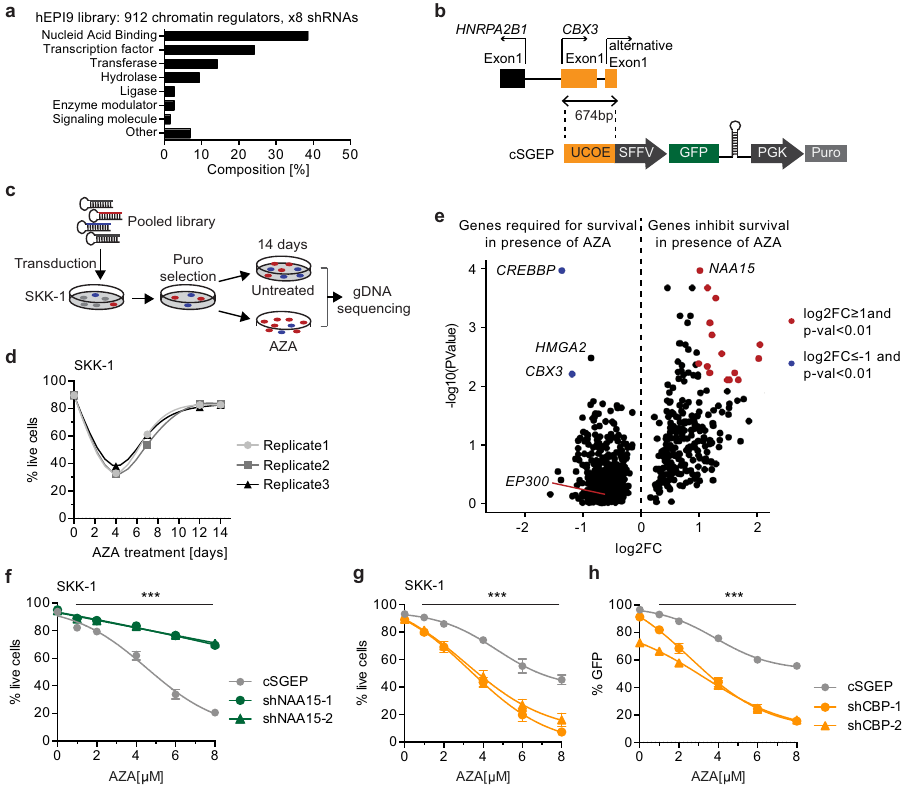
Fig. 1 Chromatin regulators affecting AZA sensitivity are identi fi ed by an optimized loss-of-function shRNA screen. a Composition of the hEPI9 library. b Illustration of the human HNRPA2B1-CBX3 locus including the ubiquitous chromatin opening element (UCOE) and schematic of the cSGEP backbone vector containing the UCOE, spleen focus-forming virus (SFFV) promoter, green fl uorescent protein (GFP) marker gene, shRNA integration site, phosphoglycerate kinase (PGK) promoter and puromycin (Puro) resistance gene. c Schematic work fl ow of the shRNA screen-targeting genes encoding chromatin regulators. d Percentage of live SKK-1 cells determined at different time points throughout the shRNA screen after initiation of AZA treatment (0.25 µ M every 2 days for 2 weeks) in three biological replicates. e Volcano plot of genes corresponding to enriched ( “ Genes inhibit survival in presence of AZA ” ) or depleted ( “ Genes required for survival in presence of AZA ” ) shRNAs. Selected genes are named. FC, fold change. CREBBP, P = 0.0001; NAA15, P = 0.0001; HMGA2, P = 0.0032; CBX3, P = 0.0061; EP300, P = 0.7405. f Percentage of live SKK-1 cells stably expressing cSGEP, shNAA15-1 or